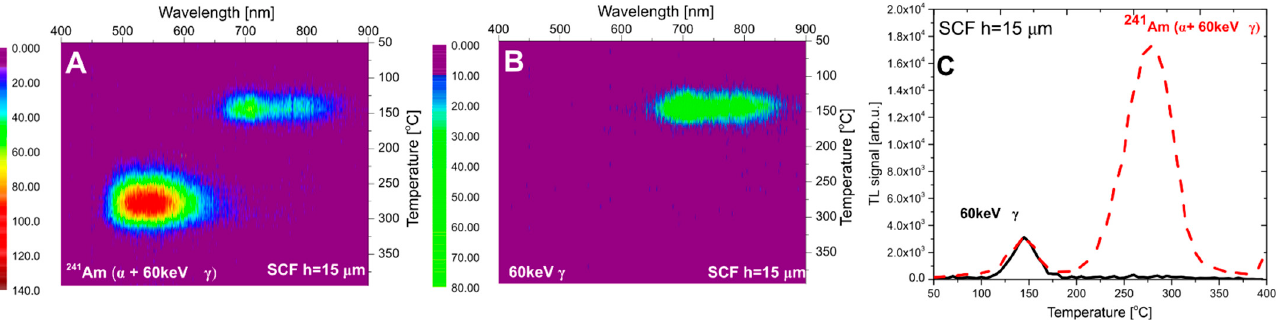
Figure 5. The emission spectra of LuAG: Ce SCF/YAGSC (h SCF = 15 μ m) (#1) after irradiation with 241 Am ( panel A —irradiation with the bare source ( α + 60 keV γ ), panel B —irradiation with the covered source (only 60 keV γ ), panel C —TL glow curves taken from spectral measurements (integration in range 400–700 nm)).